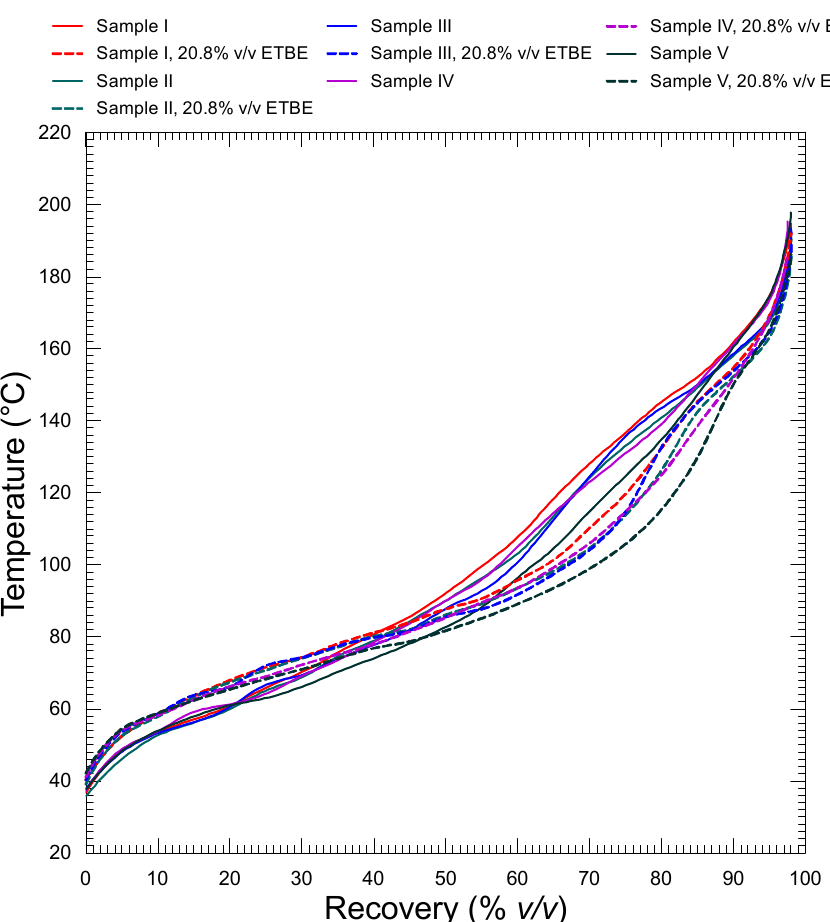
Figure 7. Distillation curves of base fuels and base fuels with 20.8% v / v bio-ETBE. The distillation characteristics E70 and E100 of Samples I, II, III, IV, and V, and bio- ethanol/ bio-ETBE blends are shown in Tables 8 and 9. The values in Tables 8 and 9 also include the expanded uncertainties for these parameters. Table 8. E70 of base fuels and bio-EtOH/bio-ETBE blends.